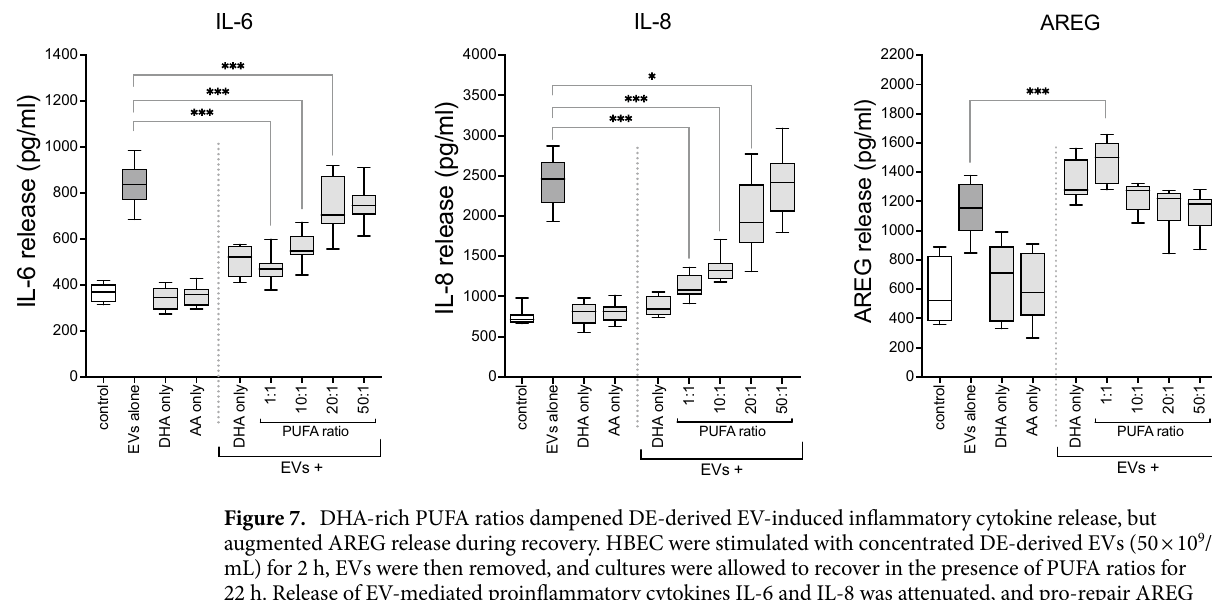
Figure 7. DHA-rich PUFA ratios dampened DE-derived EV-induced inflammatory cytokine release, but augmented AREG release during recovery. HBEC were stimulated with concentrated DE-derived EVs (50 × 10 9 / mL) for 2 h, EVs were then removed, and cultures were allowed to recover in the presence of PUFA ratios for 22 h. Release of EV-mediated proinflammatory cytokines IL-6 and IL-8 was attenuated, and pro-repair AREG was augmented by treatment with the DHA-rich (1:1) PUFA ratio and by DHA alone during the recovery phase. Data shown are means of 4 independent experiments with 24 technical replicates per condition. *p <